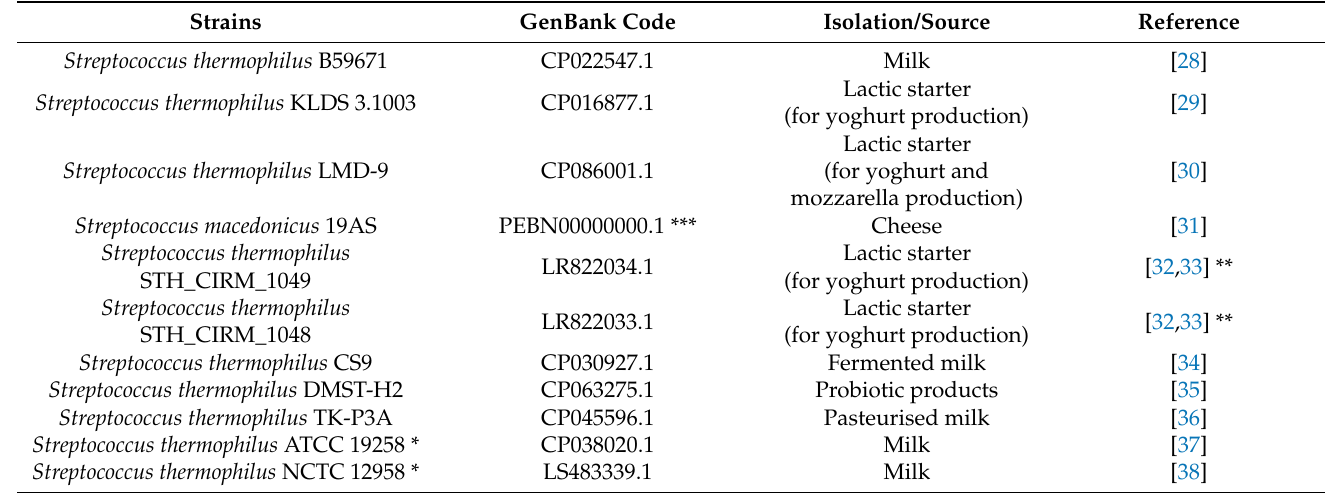
Table 1. List of strains and associated GenBank accessions code for genomes in which a 960-bp sequence with 100% identity to U93029.1 was found using